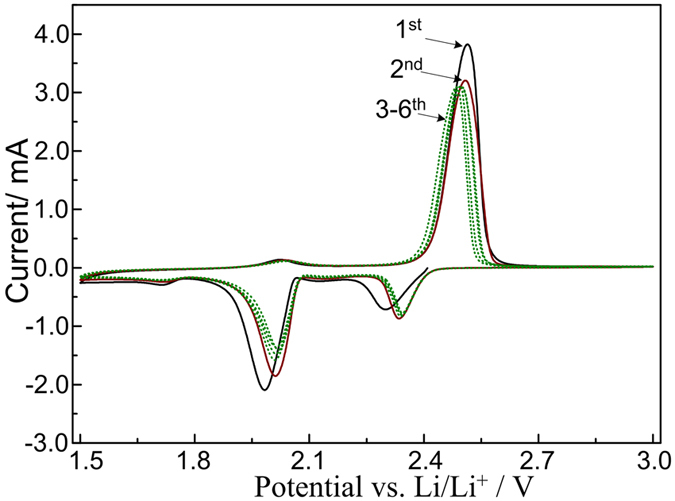
Cyclic voltammetry of the sulfur with hydrogen reduced TiO2 cathode obtained at 0.1 mV s−1.